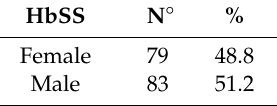
Table 3. Distribution of sickle cell anaemia by sex of newborns in the state of Maranh ã o,